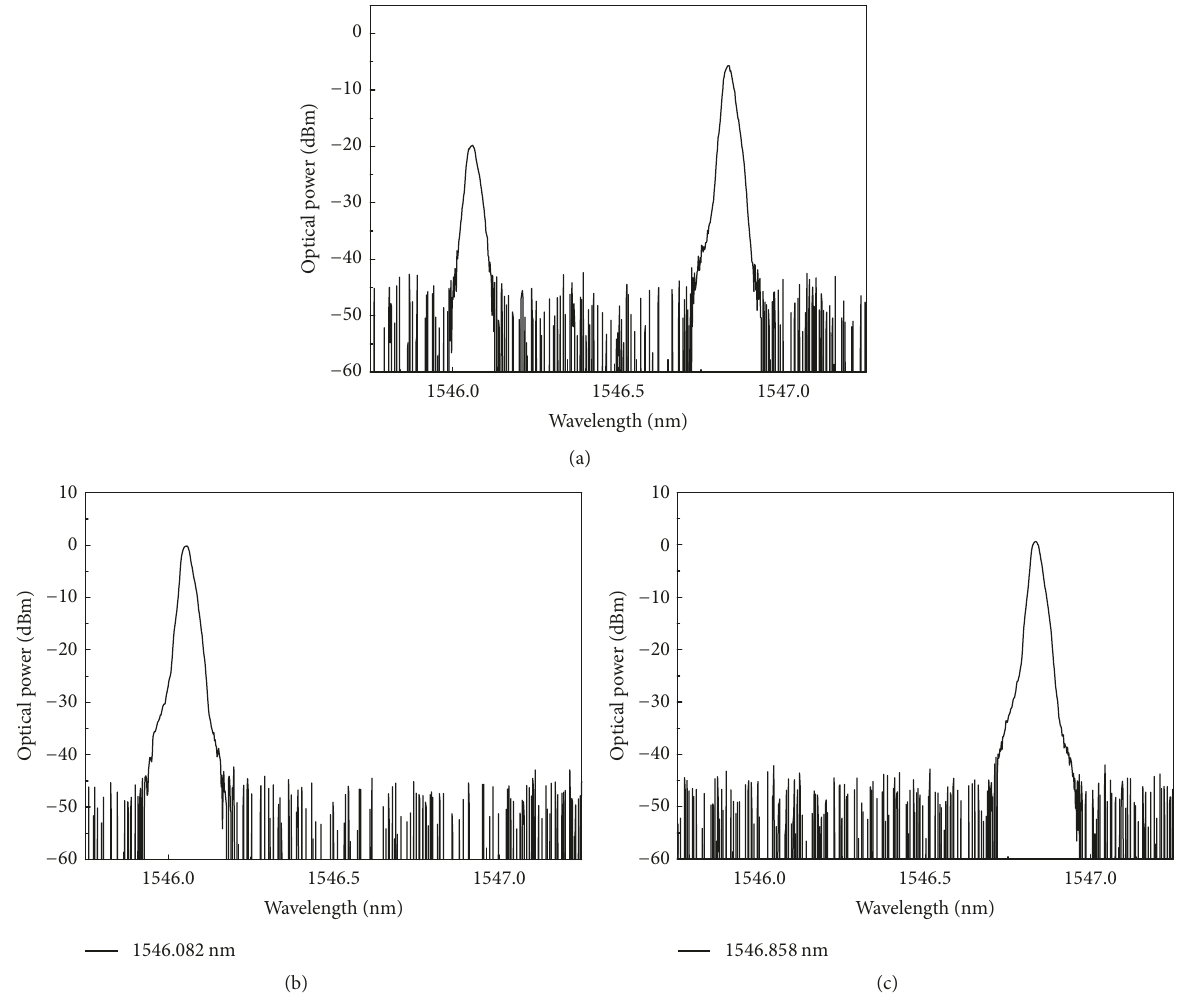
Figure 8: Optical spectrum (a) after OC, (b) after DFB1, and (c) after DFB2, as shown in Figure 7.